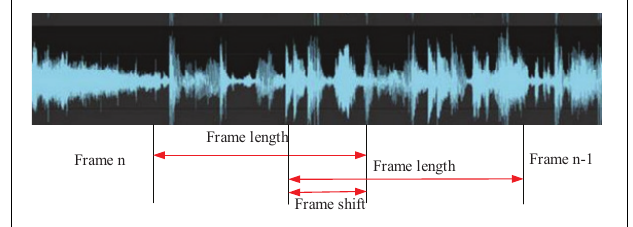
FIGURE 3 | Framing diagram of the pipa music